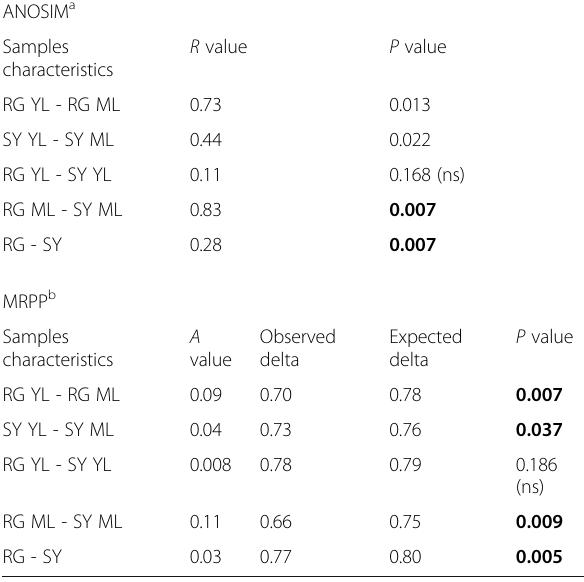
Table 2 Community structure of endophytic fungus among V . vinifera (Red Globe) and V . amurensis (Shuangyou) at young and mature stages tested by ANOSIM and MRPP ANOSIM a Samples